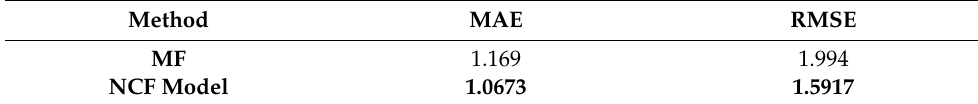
Table 9. NCF model comparison with matrix factorization technique.